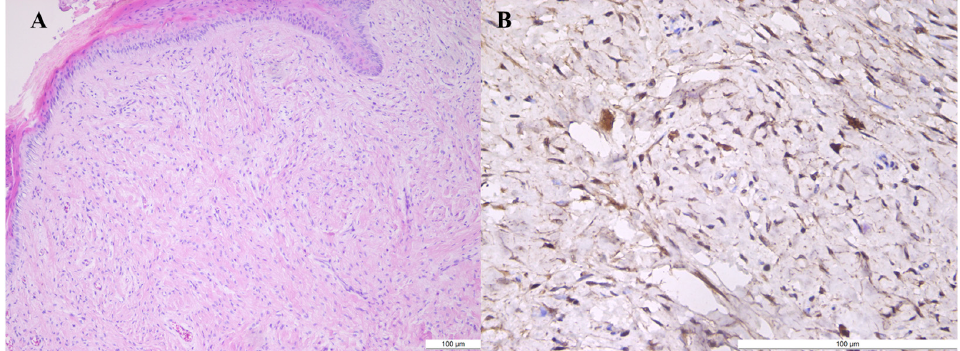
Figure 3. Neurofibroma ( A ) spindle cells with reduced cytoplasma; cells with ovoid, round or “comma” nulei; cells are separated by collagen fibers (HEx10). ( B ) S100 protein staining positive in “comma” nulei; cells are separated by collagen fibers (HE × 10). ( B ) S100 protein staining positive in tumor cell . tumor